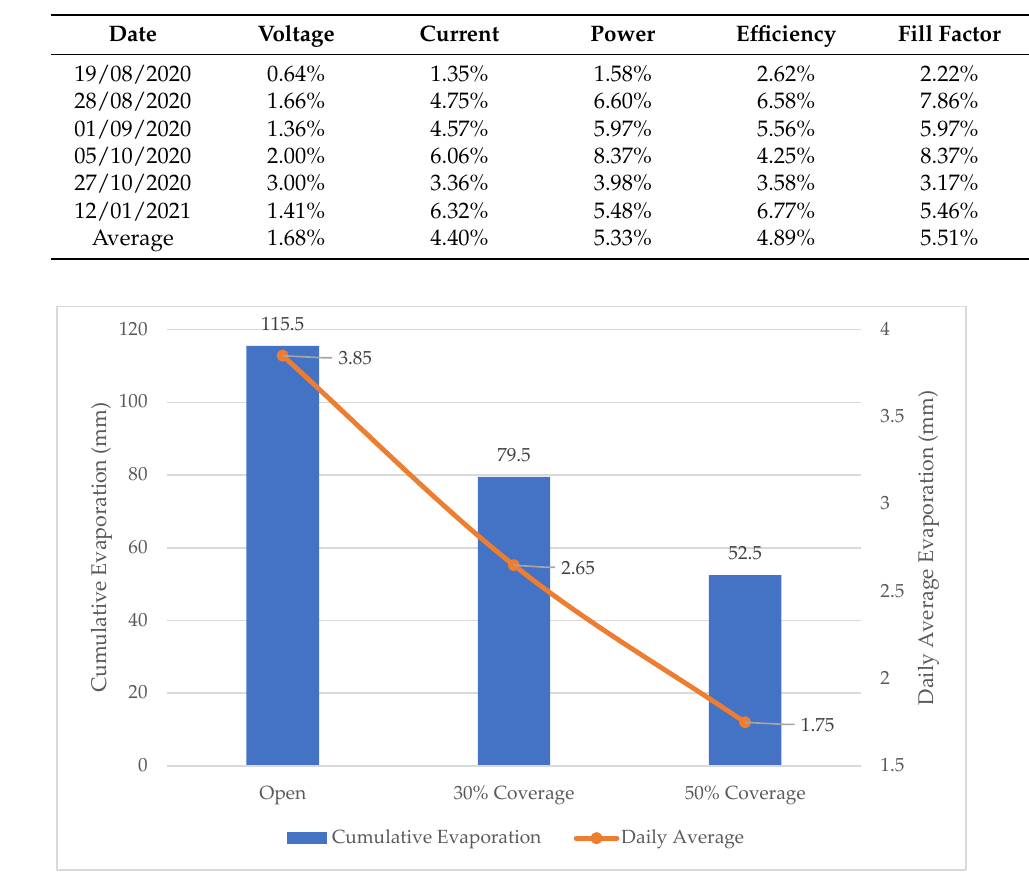
Figure 6. Cumulative and daily average evaporation measurements.